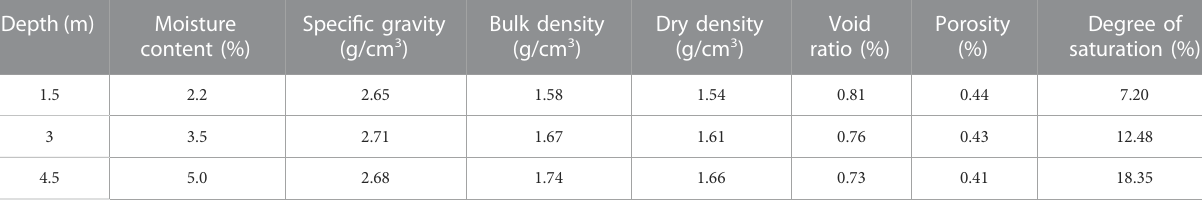
TABLE 2 Physical characteristics used in the investigation of Najran soils. Depth